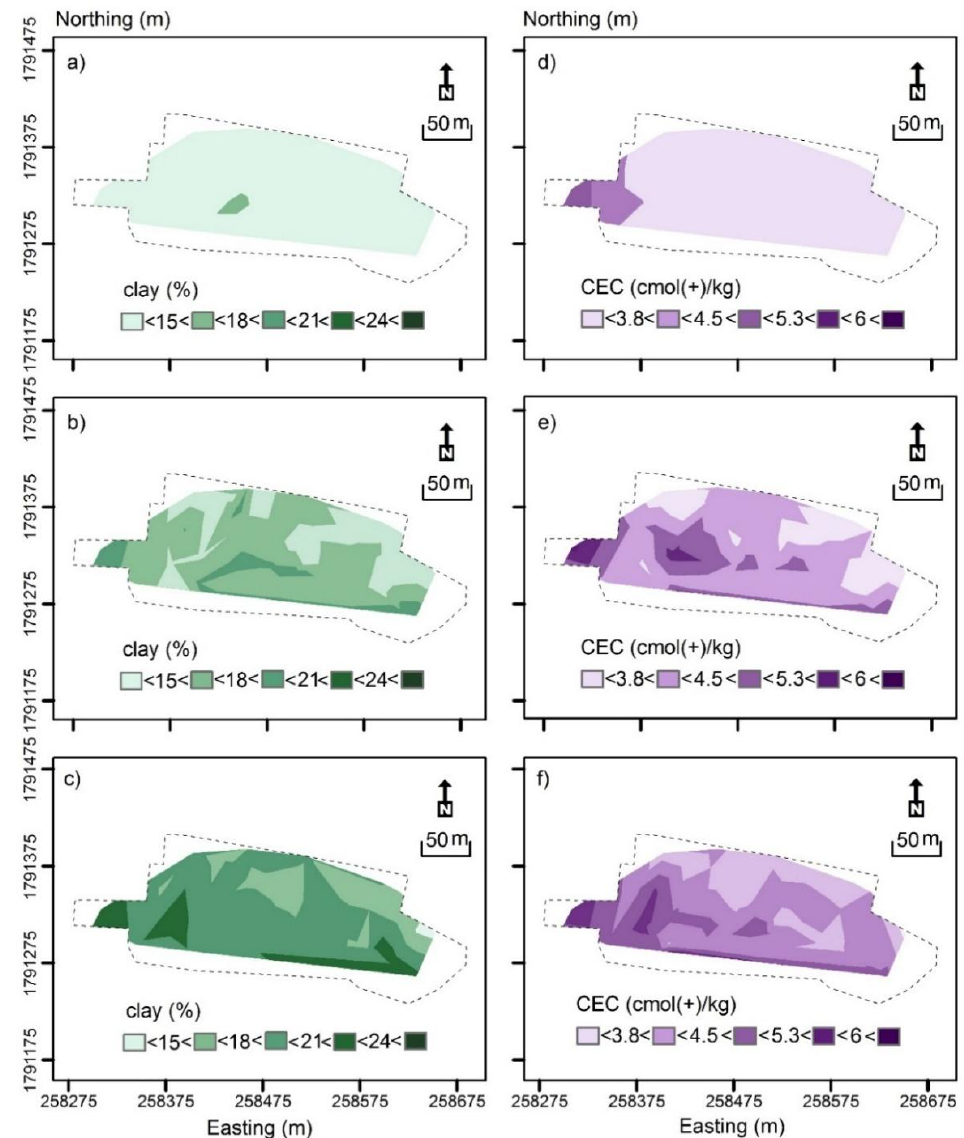
Figure 4. Contour plots of measured ( a ) topsoil (0–0.3 m), ( b ) subsurface (0.3–0.6 m) and ( c ) subsoil (0.6–0.9 m) clay (%) and ( d ) topsoil, ( e ) subsurface and ( f ) subsoil cation exchange capacity